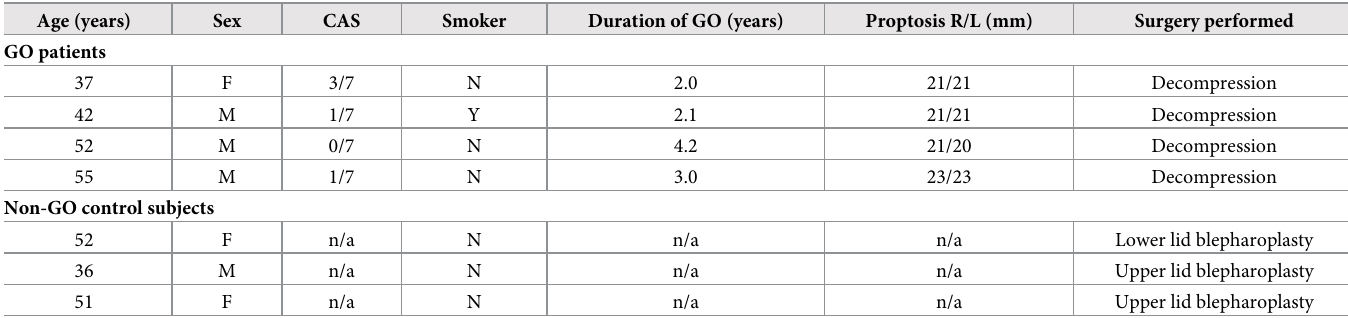
Table 1. Clinical information of patient samples used in this in vitro